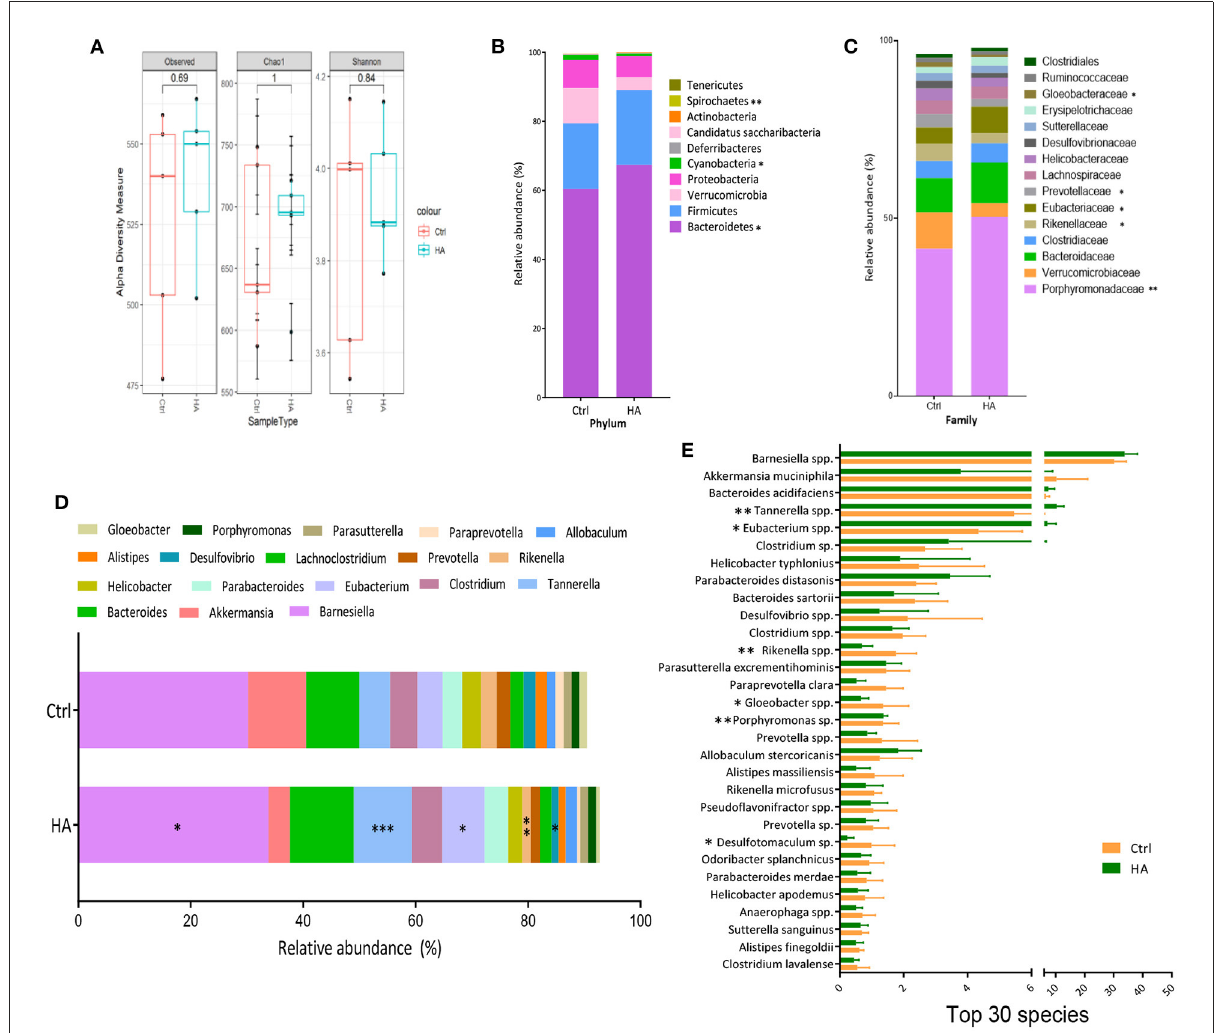
FIGURE2 HA changed the core GM composition. (A) Alpha diversity analysis of the GM compositions between the control and the HA groups. (B) The relative abundance of the dominant phyla. (C) The relative abundance of the dominant family. (D) The relative abundance of the dominant genus. (E) The relative abundance of the Top 30 species. n = 5. * p < 0.05; ** p < 0.01; *** p <